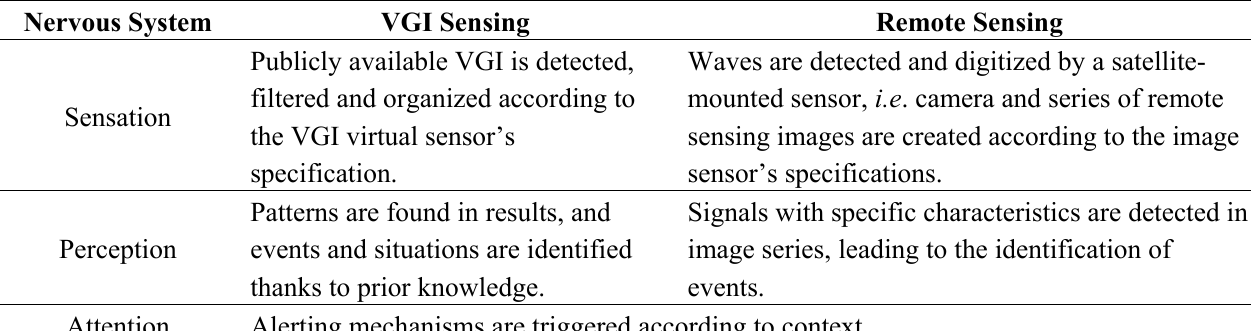
Table 2. Event detection based on Volunteered Geographic Information (VGI) sensing compared to remote sensing (adapted from